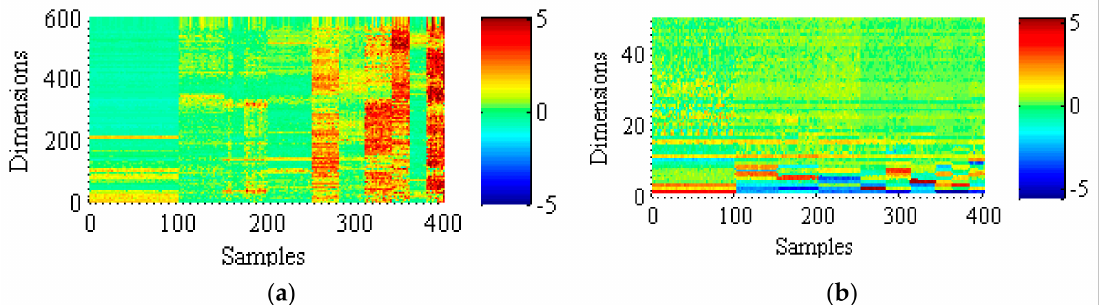
Figure 3. Feature distributions of the unlabeled target domain data based on the learned transferable features (DA task B → C): ( a ) GFK; ( b ) MRMI.